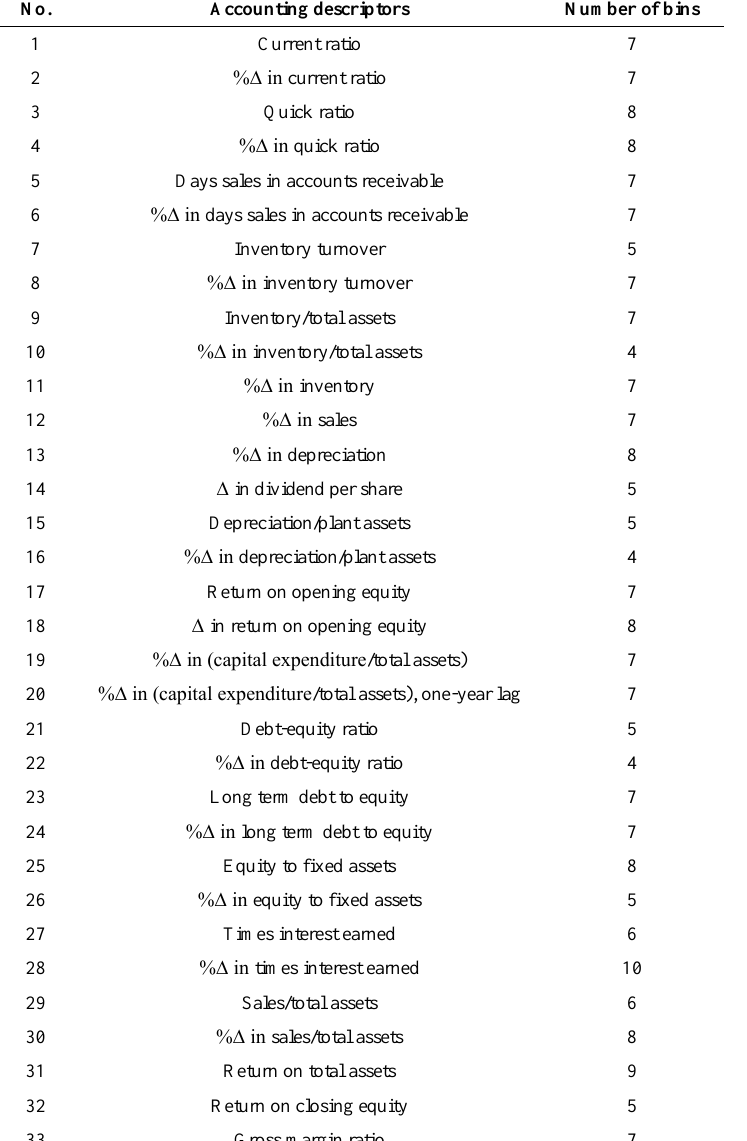
Table 5. Summary of optimal bins of all